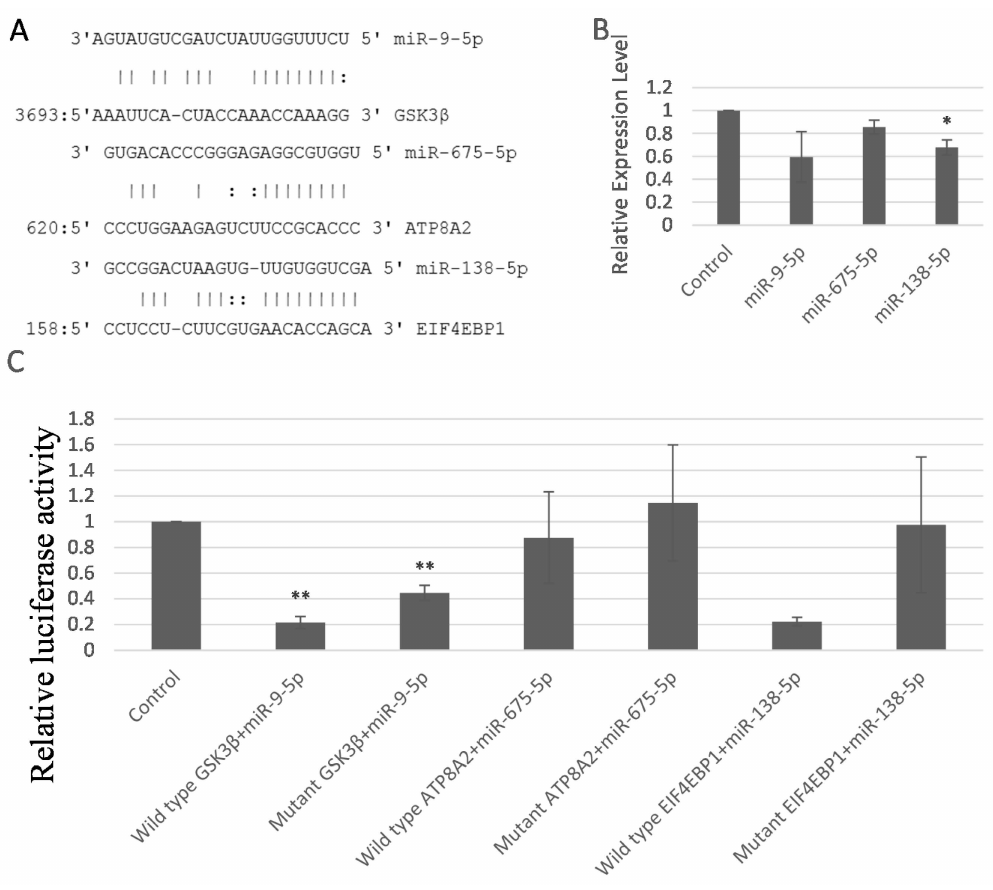
Figure 5. miR-9-5p, miR-675-5p and miR-138-5p targeted GSK3 β , ATP8A2, and EIF4EBP1, respectively. ( A ) The predicted miR-9-5p, miR-675-5p, and miR-138-5p targeting sequence located in the 3’UTR of GSK3 β , ATP8A2, and EIF4EBP1; ( B ) The mRNA level of GSK3 β , ATP8A2, and EIF4EBP1 in MC3T3-E1 cells transfected with miR-9-5p, miR-675-5p, and miR-138-5p mimics; ( C ) The relative luciferase activity of MC3T3-E1 cells transfected with miR-9-5p, miR-675-5p, and miR-138-5p mimics (20 nM for miR-675-5p and miR-138-5p, and 10 nM for miR-9-5p). * p < 0.05. ** p < 0.01. n =